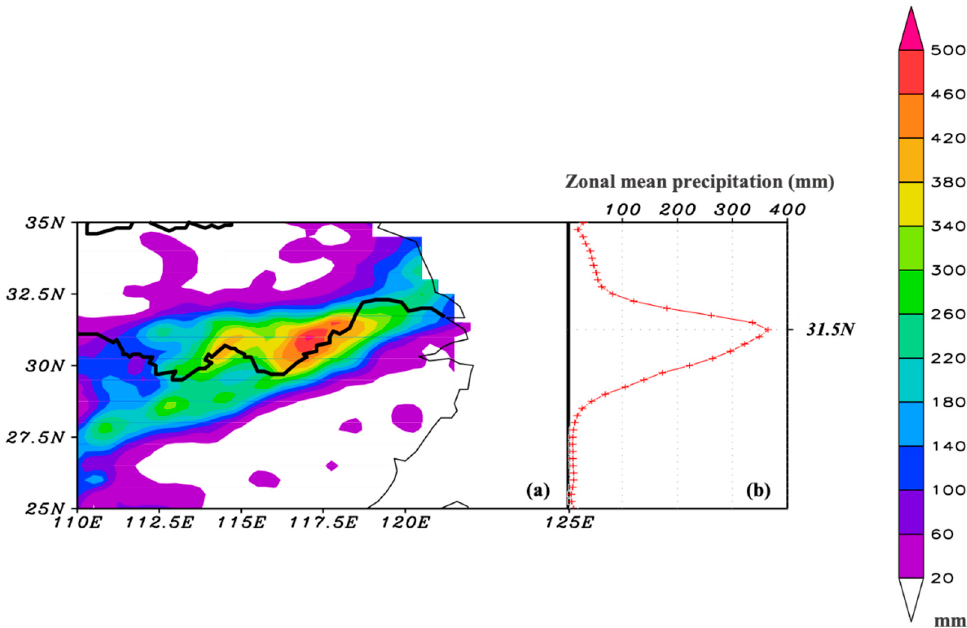
Figure 2. Observed event total accumulated precipitation for 0000 UTC 30 June–0000 UTC 5 July 2016. ( a ) Observed total accumulated precipitation from the daily rain gauge data interpolated to a 0.5° × 0.5° gridded domain. ( b ) Zonal mean (110°–120° E) of the observed 120-h accumulated precipitation (mm), maximizing at the identified zonal mean maximum accumulated precipitation (ZMCP) of 31.5° N. Thin black contours denote political boundaries and thick black lines denote the Huanghe and Yangtze Rivers to the north and south, respectively.